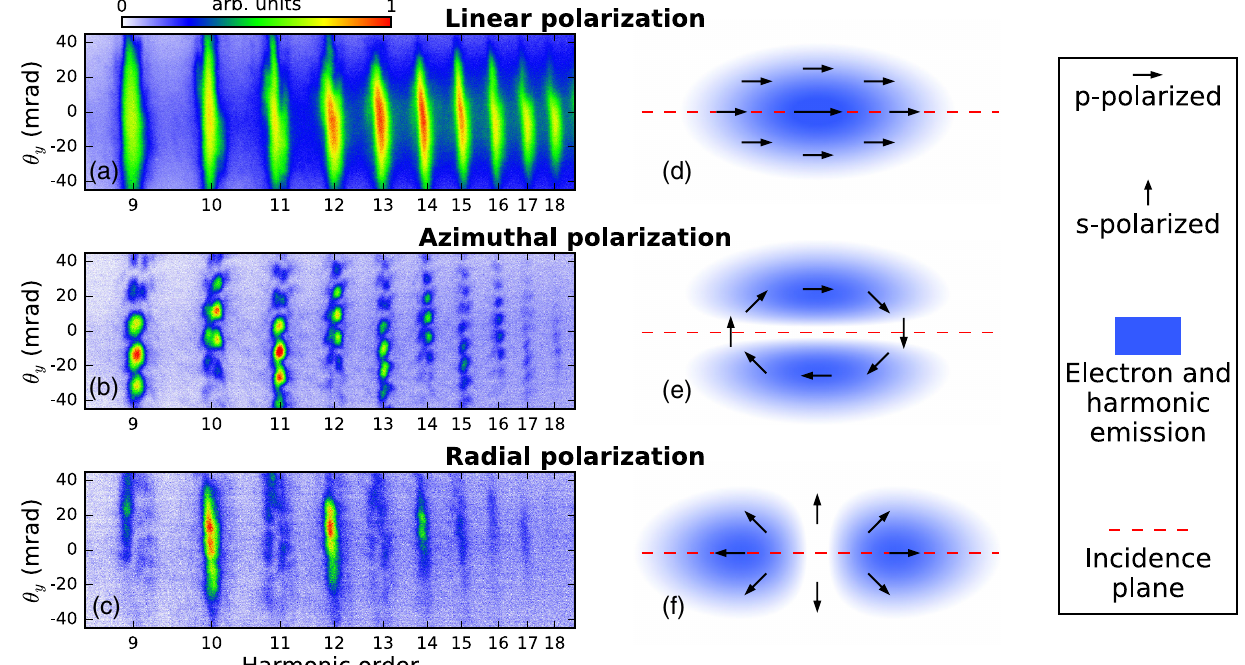
FIG. 3. (a) – (c) Experimental, angularly resolved, harmonic spectra in the case of (a) linear polarization, (b) azimuthal polarization, and (c) radial polarization. (d) – (f) Schematic view of the laser field footprint on the plasma surface for (d) linear, (e) azimuthal, or (f) radial polarization. Electrons and harmonics are only emitted when the laser is close to p-polarized (i.e., when the electric field is almost parallel to the incidence plane), which results in two spatially separated sources in the case of radial and azimuthal